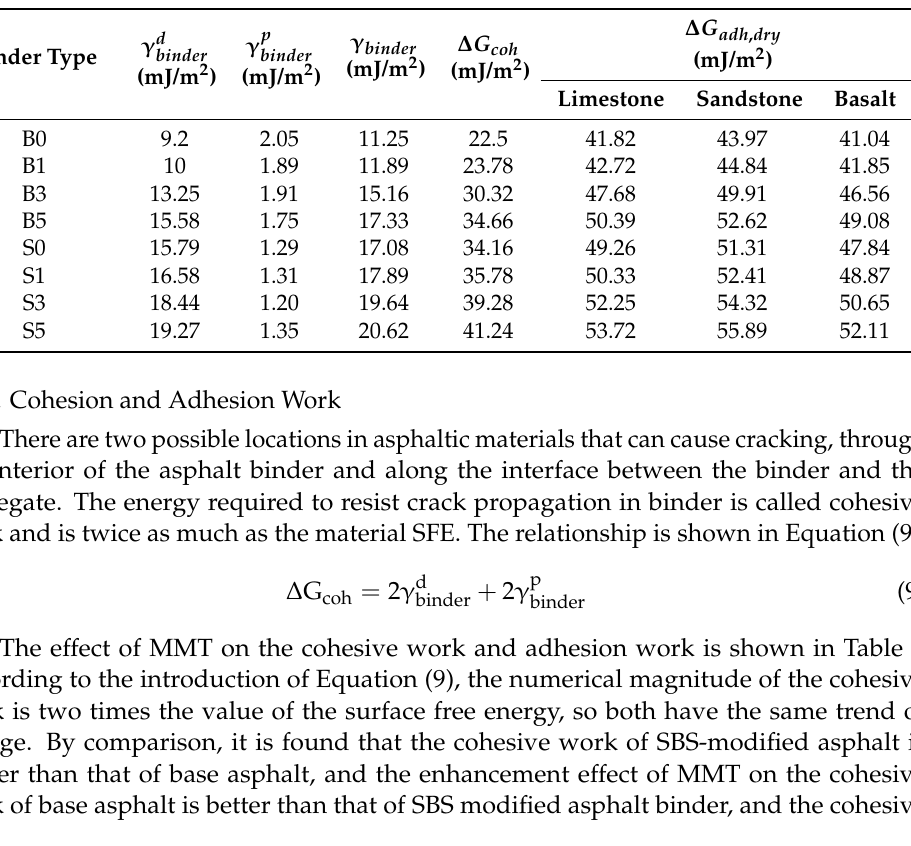
Table 7. Test results of work of cohesion of asphalt binders and work of adhesion to aggregate.